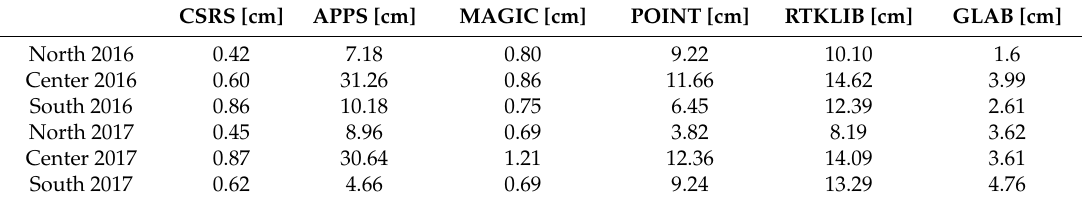
Table 4. RMSE values in centimeters by groups for day April 27th 2016 and 2017.